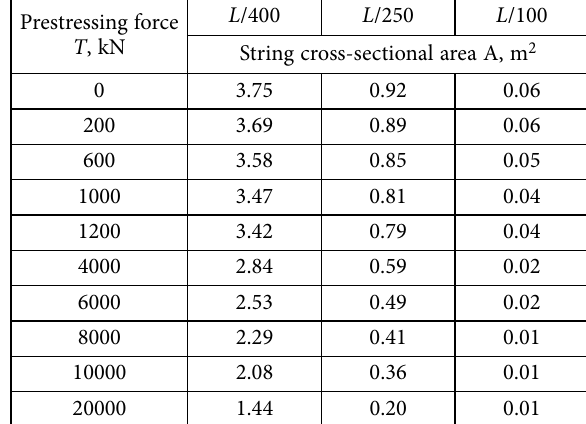
Table 1. Dependence of the required cross-sectional area of the string on the limit displacements and prestressing force at L = 25 m Prestressing force T , kN